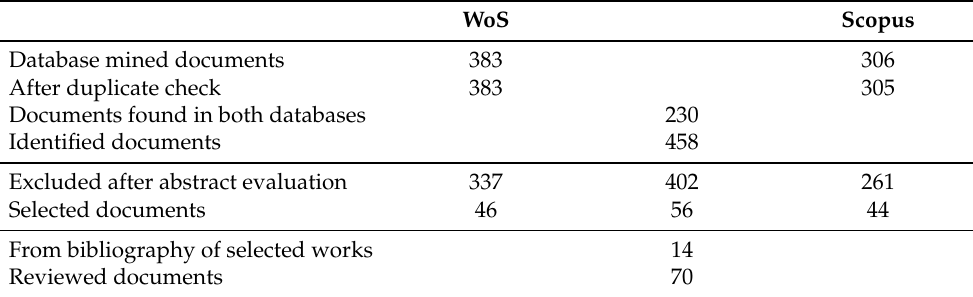
Table 2. Summary of identification, selection, and full-text examination stages.